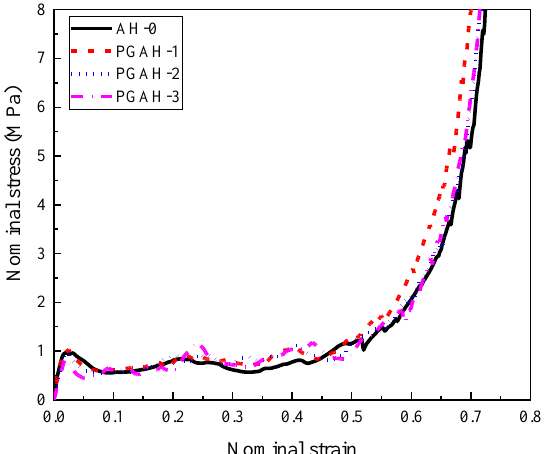
Figure 13. The comparison of the stress–strain relationships of the homogenous composite and graded composite with different cell-wall thickness gradients subjected to low-velocity impact (1 m/s).